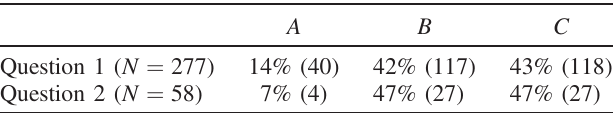
TABLE I. Percentage of sophomore-level students who chose each answer option for questions 1 and 2. The number of students selecting each option is given in parentheses.